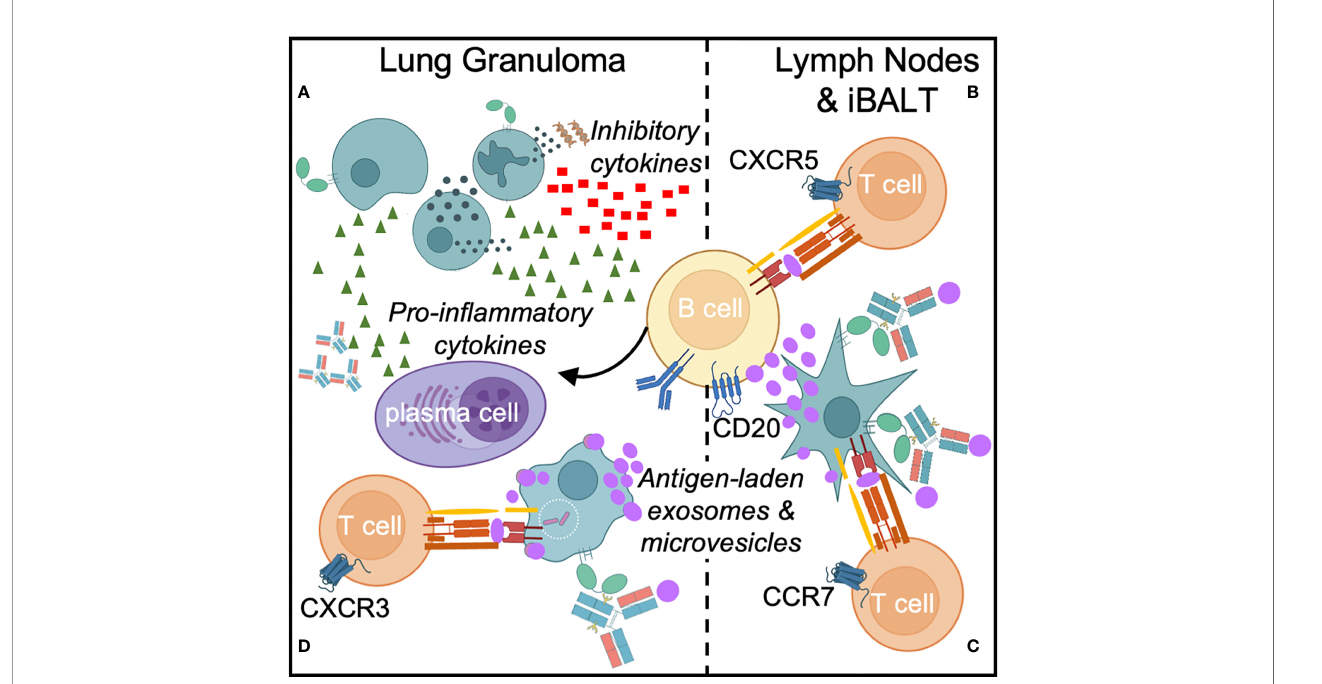
FIGURE 3 | Direct and indirect B cell responses occur in Mtb infection. Direct responses include cytokine production and differentiation of B cells speci fi c into plasma cells that secrete Mtb -speci fi c antibodies (A) . In response to Mtb infection in the lung, B cell effectors such as memory B cells, plasmablasts and plasma cells secrete pro-in fl ammatory cytokines (TNF a , IFN g , IL2, IL6, GM-CSF and CCL3), while a subset of B cells can secrete inhibitory cytokines, such as IL10, which limits Th17 cell and neutrophil in fi ltration. In secondary and tertiary lymphoid organs such as lymph nodes and inducible bronchus-associated lymphoid tissue (iBALT), B cells facilitate antigen presentation to T cells (B, C) . B cells receive T cell help from Tfh cells to initiate germinal center responses (B) and might also participate in priming T cells through the transfer of Mtb antigens (purple) to dendritic cells via exosomes and extracellular microvesicles (C) . Finally, Fc-FcR interactions can enhance Mtb phagocytosis, macrophage and dendritic cell effecror functions, and antigen presentation to T cells in the lung granuloma (D)